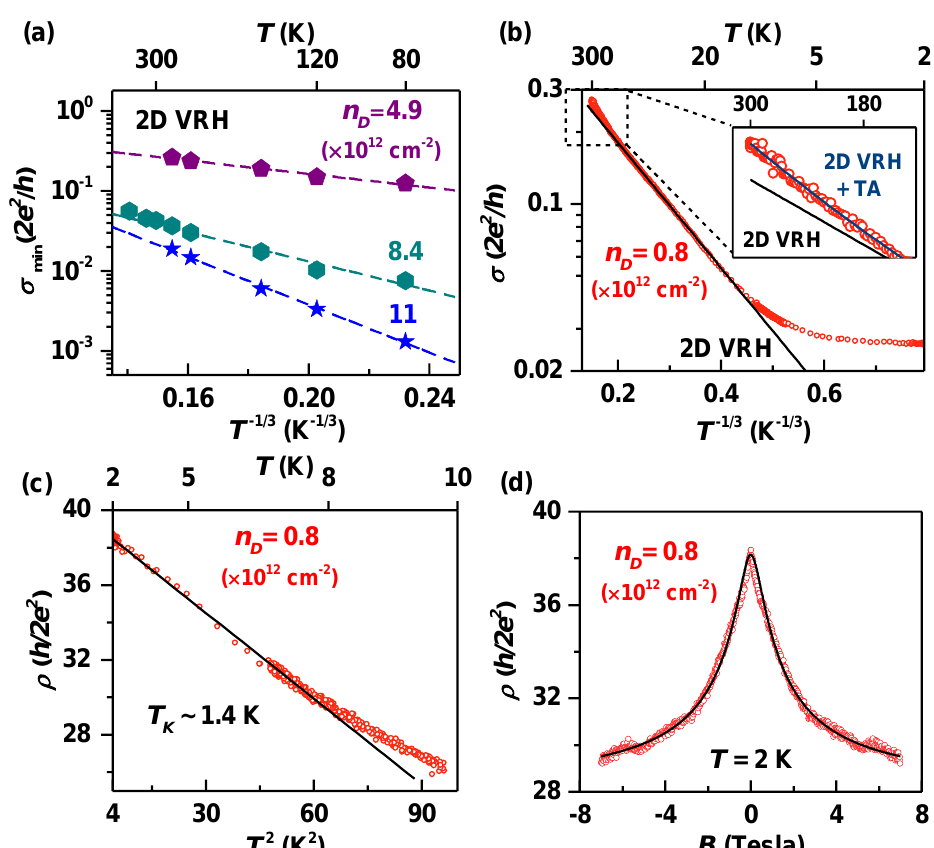
Figure 5. ( a ) log σ min vs. T − 1/3 for graphene oxides with n D = 4.9, 8.4, and 11 × 10 12 cm − 2 . ( b ) log σ vs. T − 1/3 for graphene oxide with n D = 0.8 × 10 12 cm − 2 , measured between 2 < T < 300 K. For 15 < T < 145 K, log σ is linearly proportional to T − 1/3 and agrees well with 2D VRH model. (Inset) log σ vs. T − 1/3 , zoomed in for 300 < T < 140 K. The data are best fitted considering both 2D VRH and thermal activation conduction. ( c ) ρ vs. T 2 in the low T regime for 2 < T < 10 K for GO with n D = 0.8 × 10 12 cm − 2 . ( d ) Magnetoresistance of the graphene oxide with n D = 0.8 × 10 12 cm − 2 , measured at T = 2